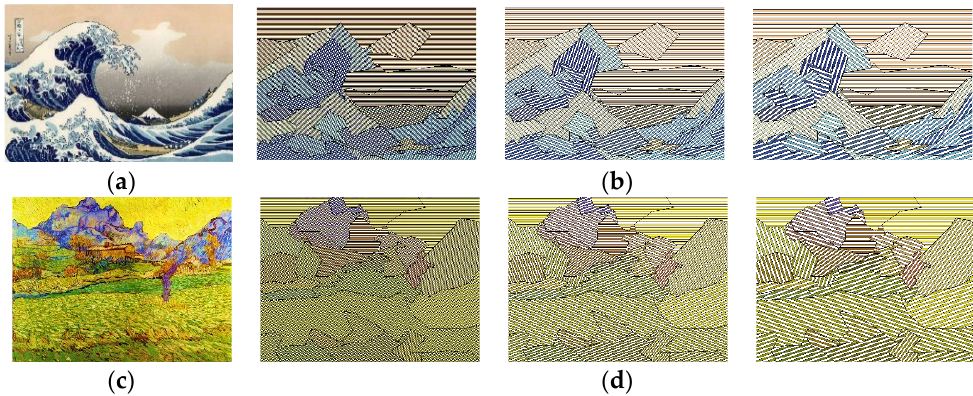
Figure 4. Stripe-based Futurism-like images generated in this study. ( a ) An original image, “The Great Wave off Kanagawa”, by Katsushika Hokusai, 1831. ( b ) Three stripe-based Futurism-like images with stripes of different widths generated in this study with Figure 4a as the input. ( c ) Another original image, “A Meadow in the Mountains”, by Vincent van Gogh, 1889. ( d ) Three stripe-based Futurism-like images with stripes of different widths generated in this study with Figure 4c as the input.